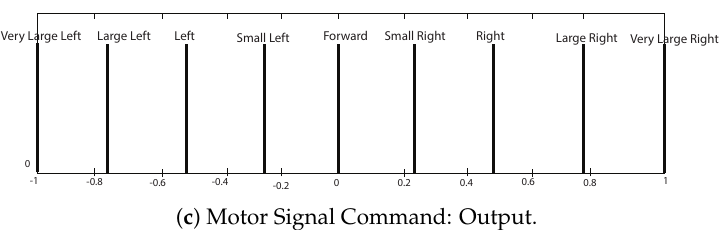
Figure 5. Fuzzy Membership Functions for the Run-To-Goal